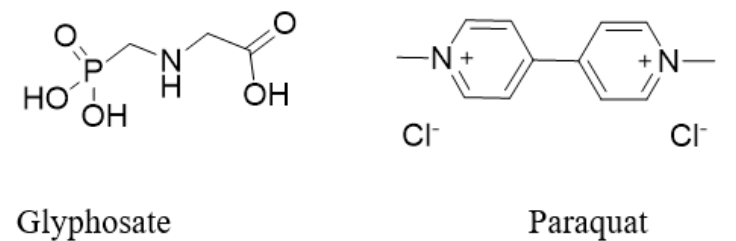
Figure 1. Prediction of phloem mobility of Kleier model.